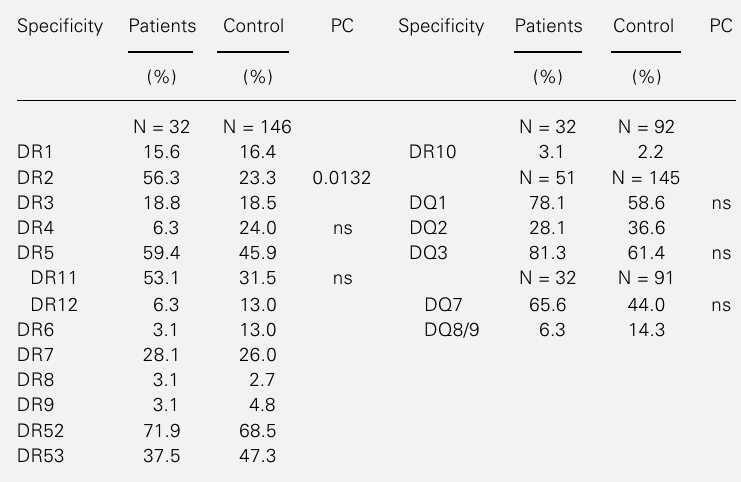
Table 3 - HLA-DR and DQ antigen frequencies in patients with the TT form of leprosy and in the control group. ns = Nonsignificant (indicated only if P<0.05 before correction); P = probability; PC = corrected probability (Chi-square